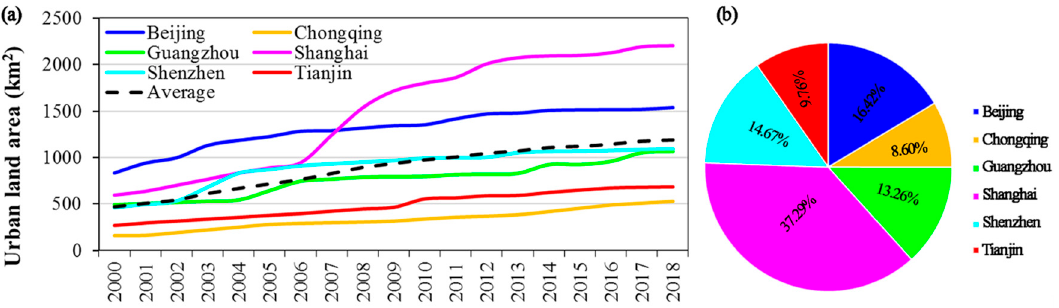
Figure 4. Urban land expansion of China’s megacities during 2000–2018: ( a ) Areas and ( b ) contribution rates to total expanded areas.